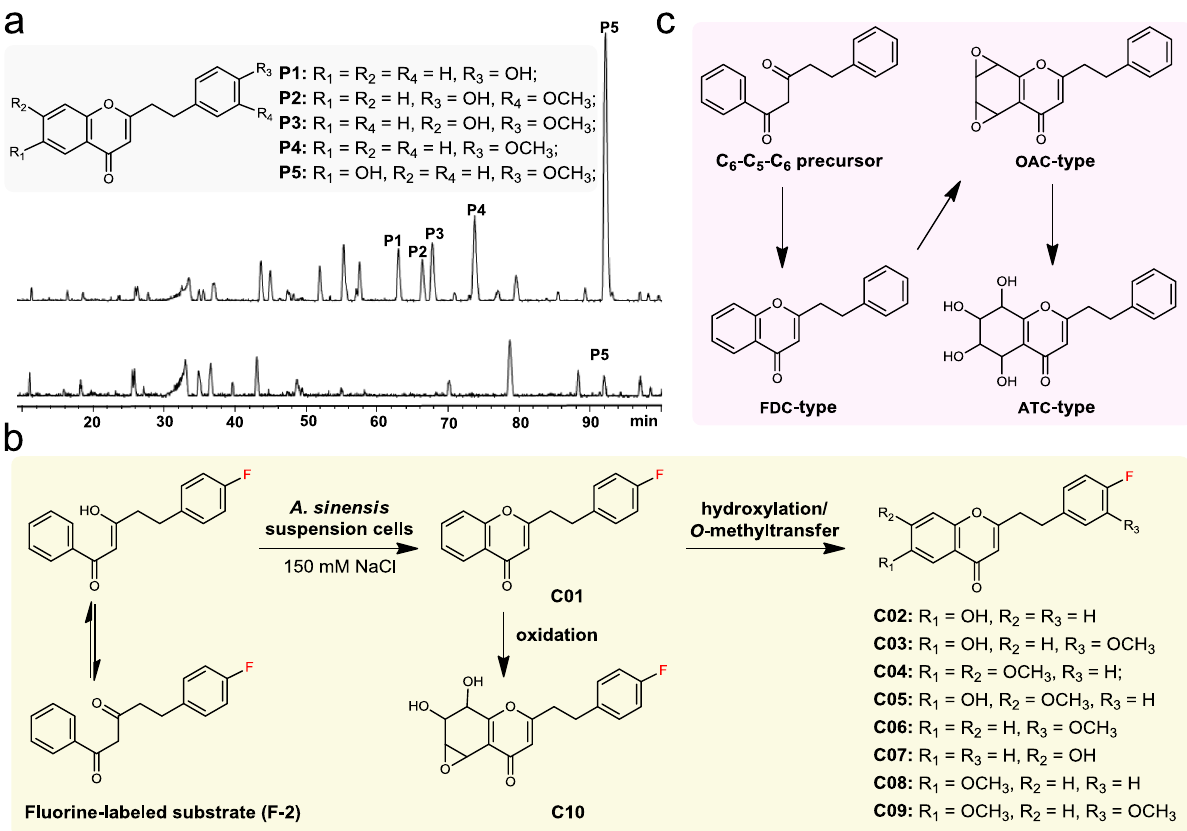
Fig. 2 Biotransformation of the diarylpentanoid-precursor to structurally varied PECs. a HPLC chromatogram of PECs produced by suspension cells fed with 5-(4-hydroxyphenyl)-1-phenylpentane-1,3-dione ( 2 ). b Conversion of fl uorine-labeled substrate ( F-2 ) to structurally varied fl uorinated PECs by suspension cells. c Proposed biosynthetic pathway of the three types of PEC